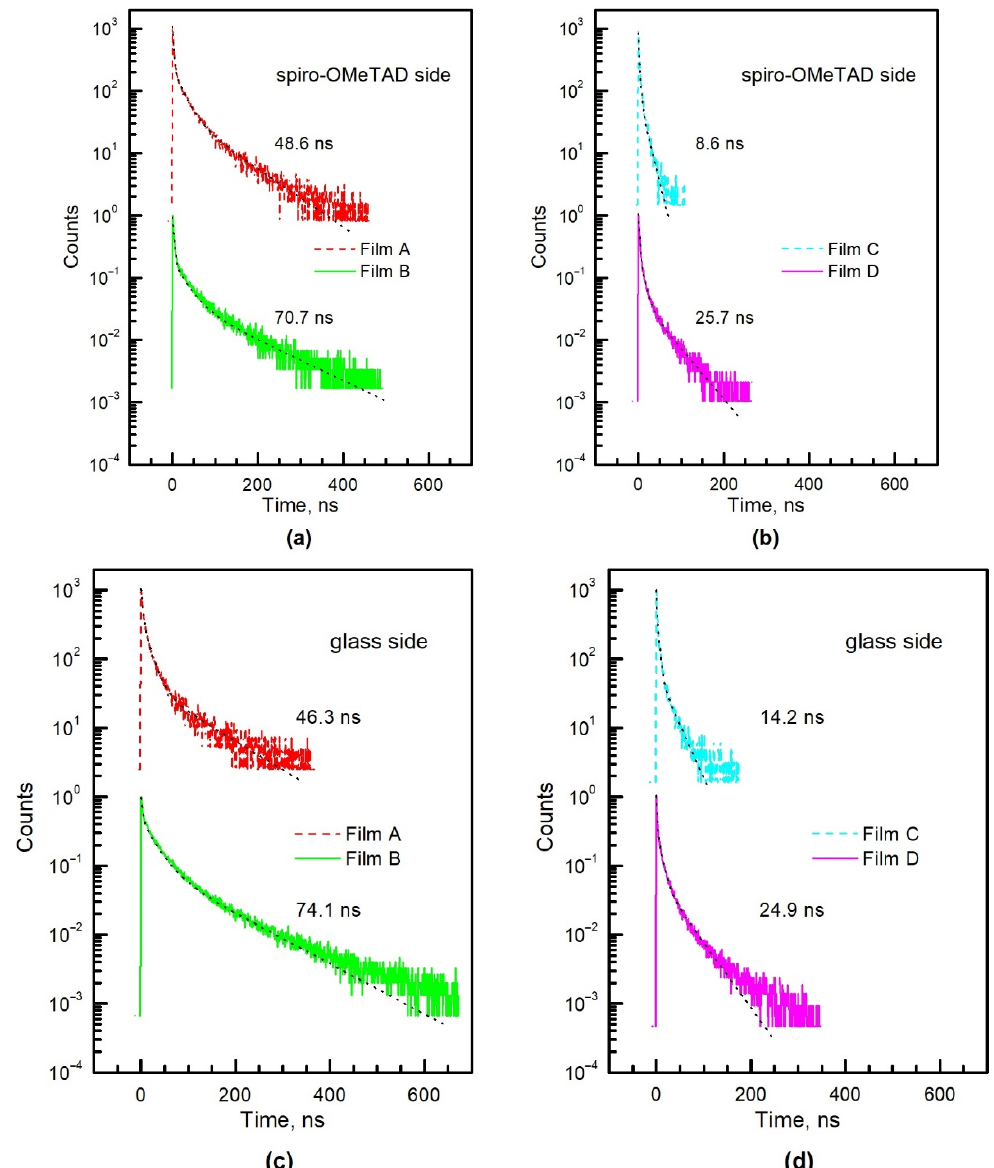
Figure 8. PL decay transients of PSC measured from the spiro-OMeTAD side ( a , b ) and from the glass side ( c , d ). Black dotted lines indicate triple exponent approximation fitting, and the numbers (in ns) are the averaged decay time constants. Table 2. Results of PL spectra analysis. k is the slope of log I PL versus log P curve; A i and τ i are the amplitude and the decay time constant of the i th term in Equation (1); τ dec is average decay time calculated using Equation (2).